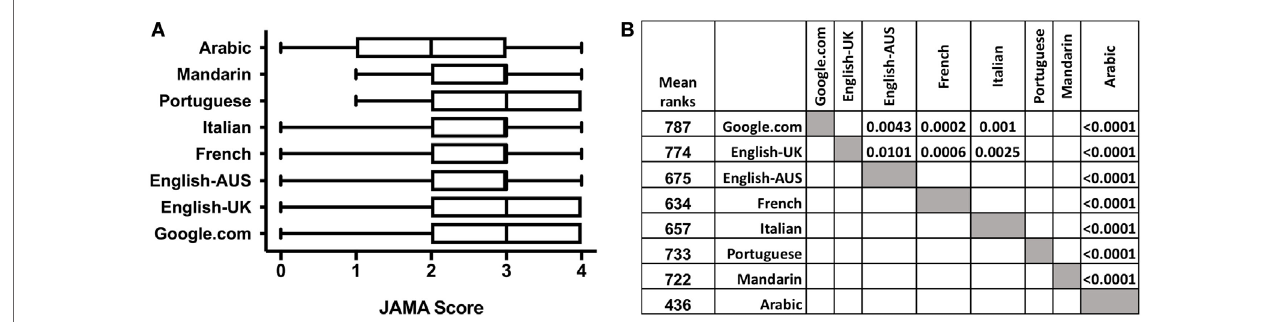
FigUre 5 | JAMA score of webpages in the different search engine result pages (SERPs). (a) Box-and-whiskers graph indicate median, 25 and 75% percentiles, minimum and maximum. (b) Multiple comparison of different SERPs. P -values are reported only for statistically significant differences. Multiple comparison of JAMA scores among the different SERPs was performed using ANOVA followed by Kruskal–Wallis test corrected for multiplicity by controlling the false discovery rate using the method of Benjamini and Hochberg for 28